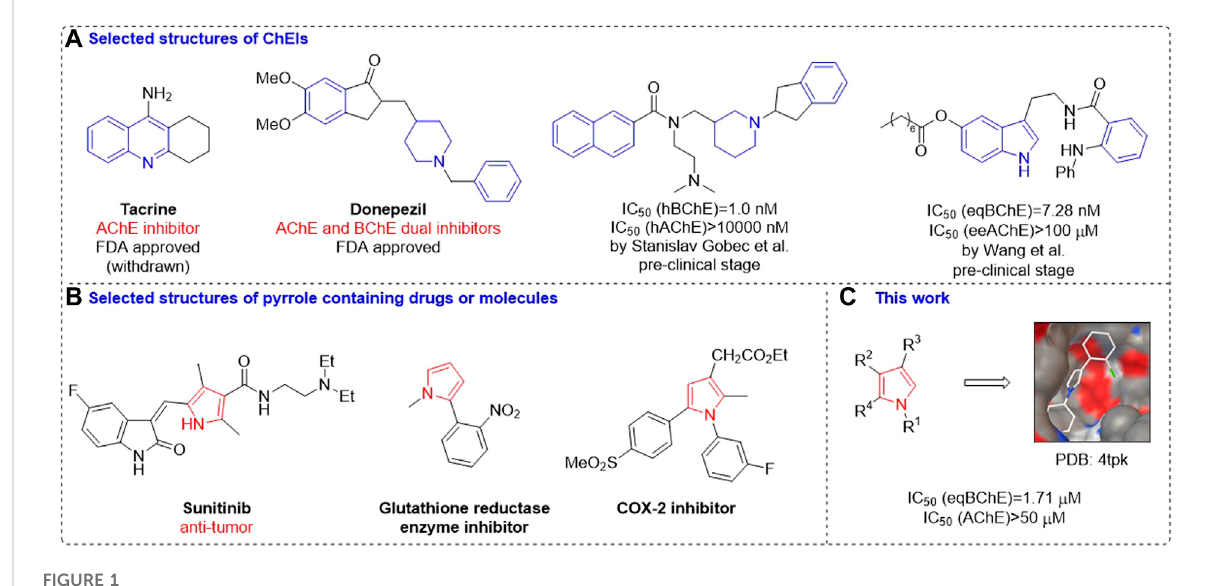
FIGURE 1 Selected structures of ChEIs (A) ; Selected structures of pyrrole containing drugs or molecules (B) ; This work (C)